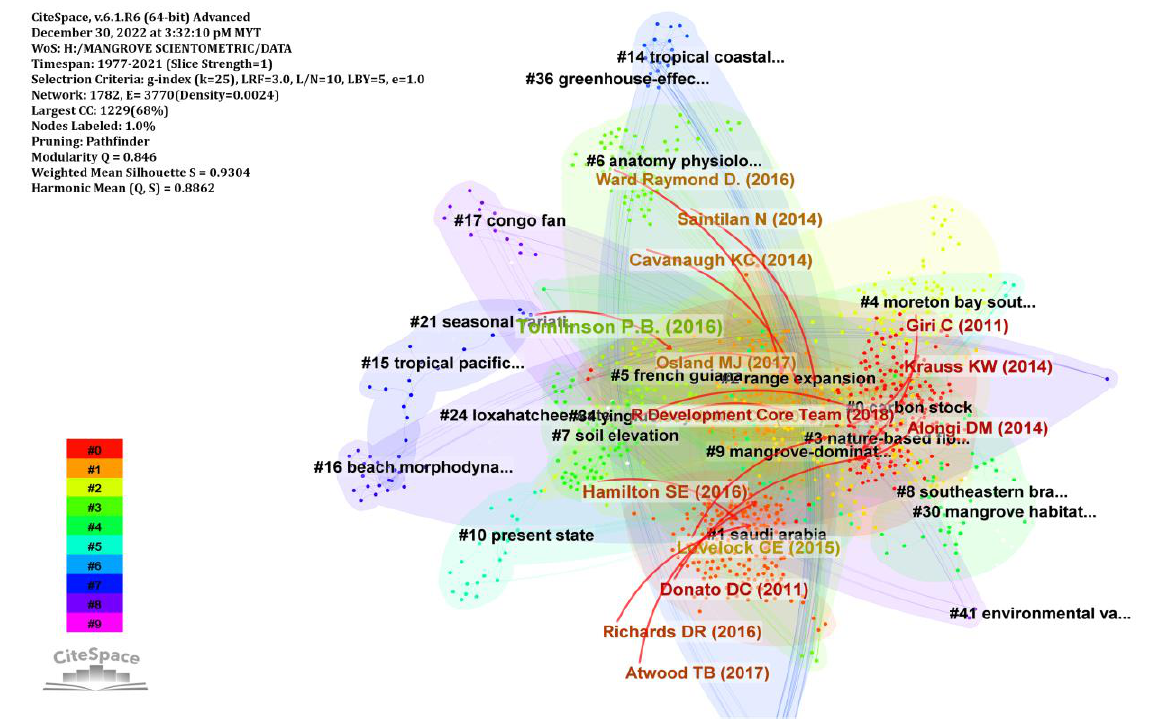
Figure 8 . Document co-citation clustering analysis for mangrove and climate change publications. Table 4. Co-citation analysis of major citing articles pertinent to mangrove and climate change (2010 – 2021).